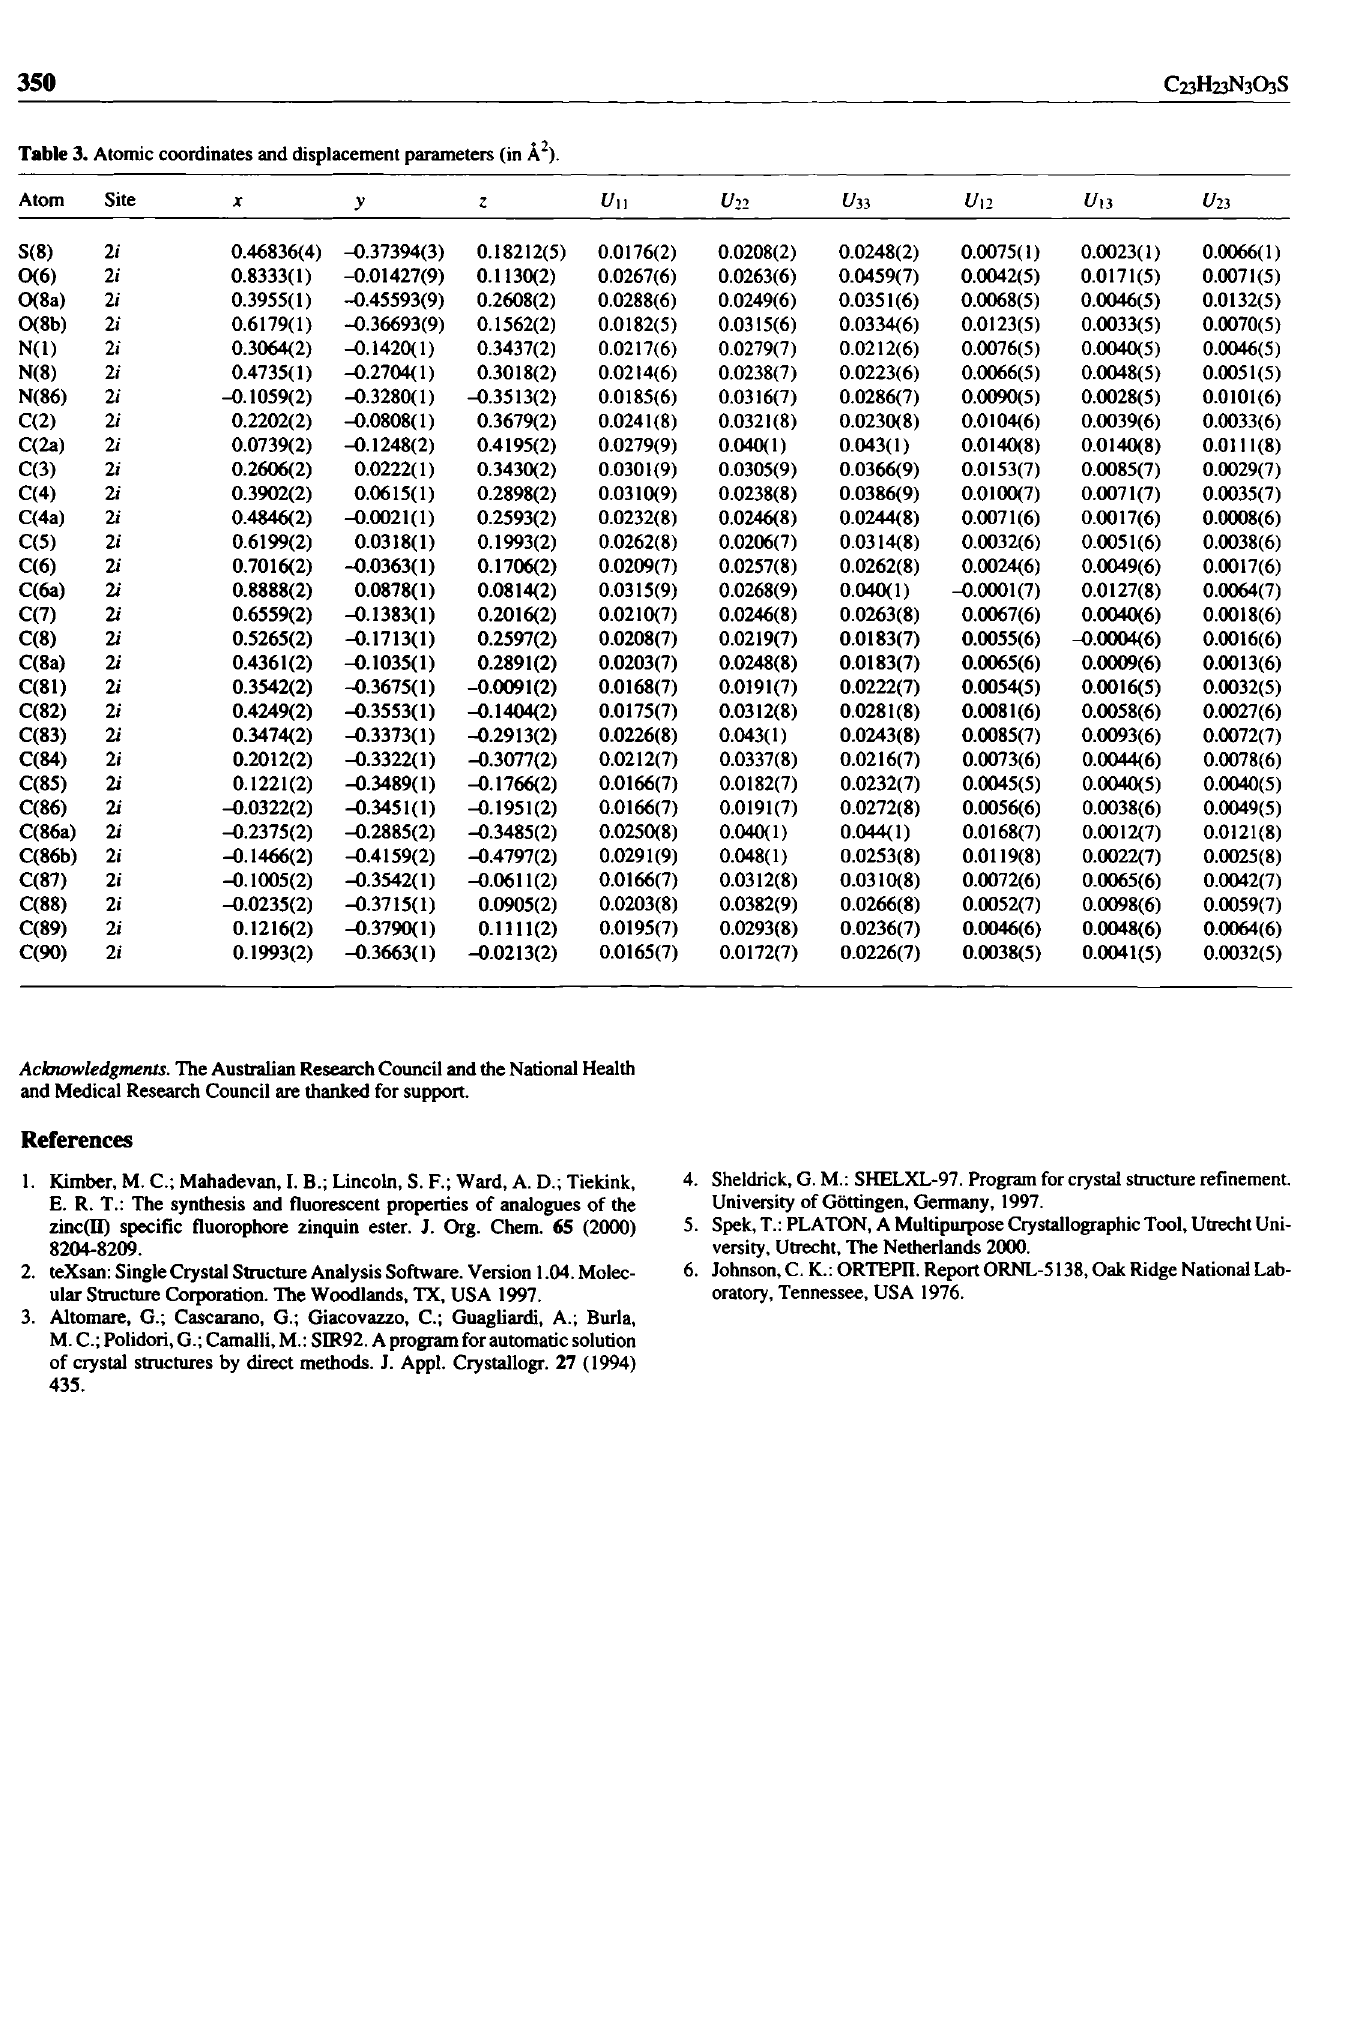
Table 3. Atomic coordinates and displacement parameters (in Â 2